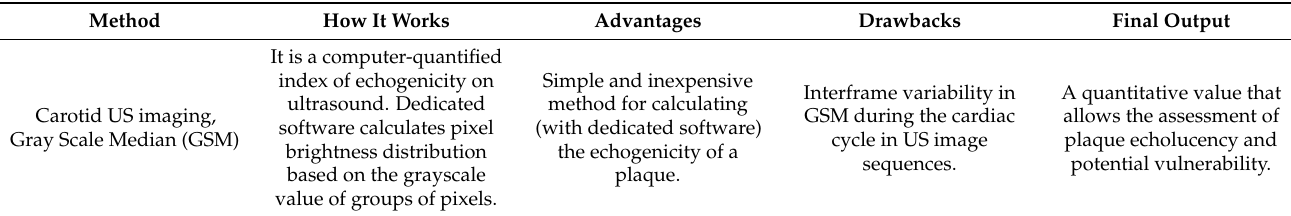
Table 2. Advantages and drawbacks of different ultrasound methods for characterizing carotid plaques.